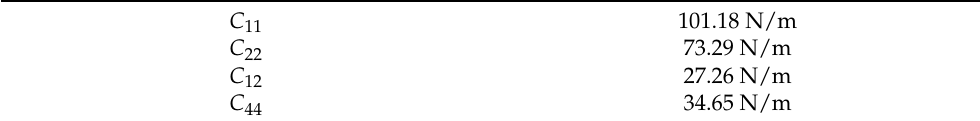
Figure 4. Band structure ( a ) and LDOS ( b ) for the Cu 2 TeO 6 monolayer. The Fermi level is represented by the dashed green line. Table 2. The calculated elastic constants C ij for the Cu 2 TeO 6